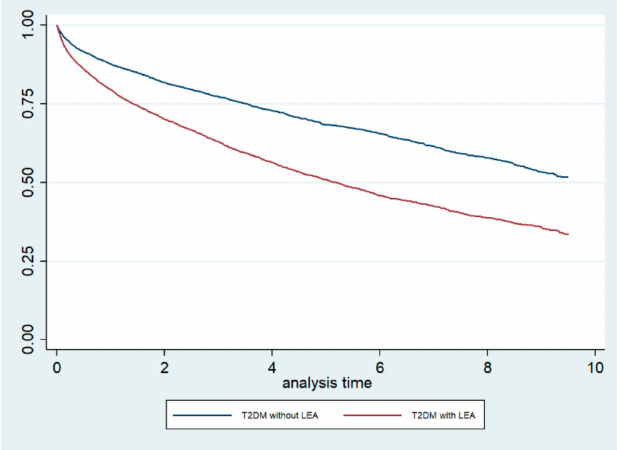
Figure 1. Kaplan–Meier survival curves, stratified for lower extremity amputation (LEA) status, among type 2 diabetic (T2DM) patients in the Autonomous Community of Madrid (Spain) from 2006 to 2015.